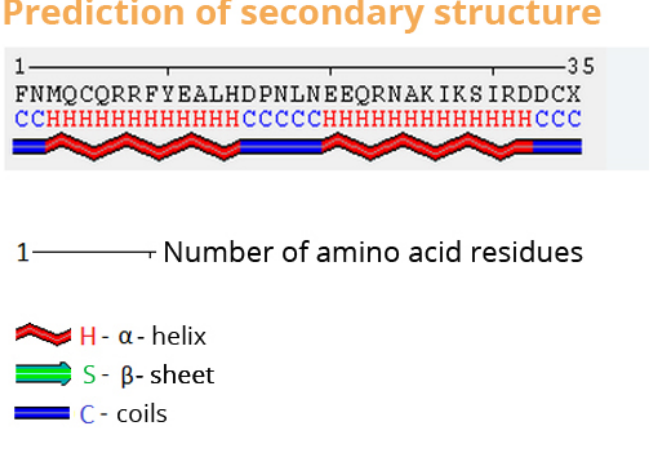
Figure 8. wCReF results page. Secondary structure